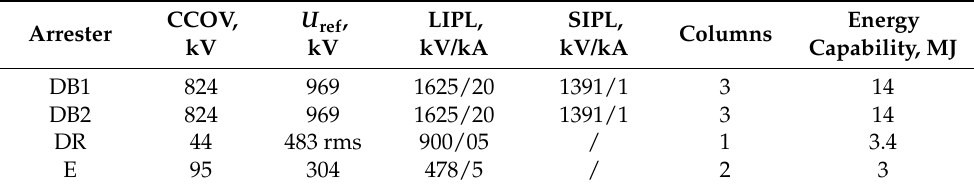
Table 4. Parameters and protection levels for arresters.